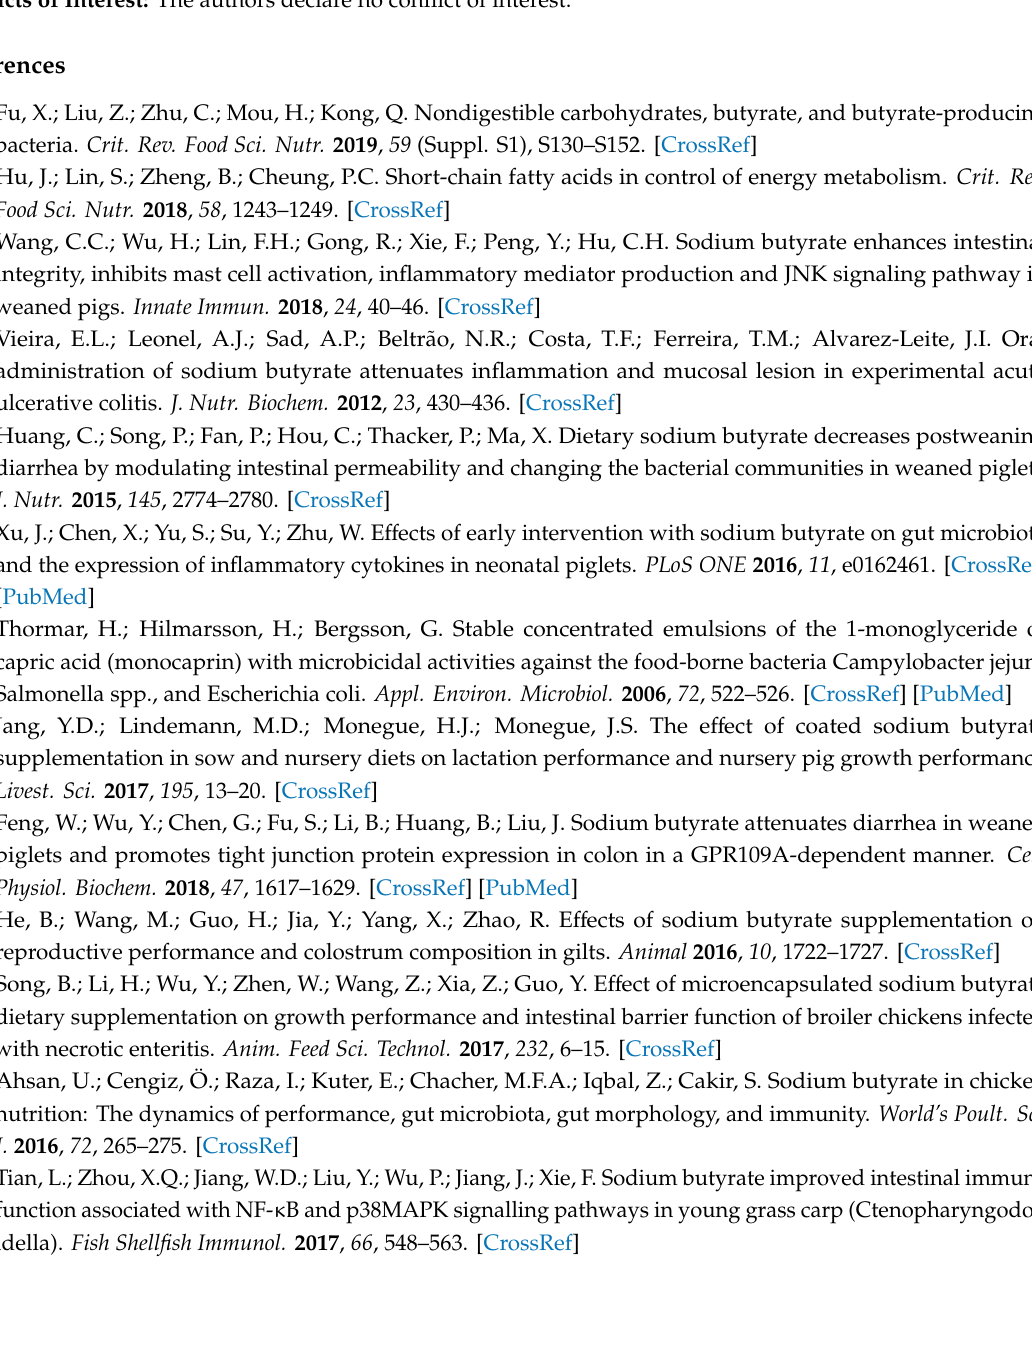
Table S1: Relative standard deviation (RSD) of the retention time of internal standard in QC. Table S2: Metabolites in the serum of growing pigs identified by gas chromatograph-mass spectrometry analysis. Table S3: Di ff erential metabolites between the Con group and SB group within the whole period. Table S4: Di ff erential metabolites between the Con group and SB group at 0 min. Table S5: Di ff erential metabolites between Con group and SB group at 30 min. Table S6: Di ff erential metabolites between Con group and SB group at 60 min. Table S7: Di ff erential metabolites between Con group and SB group at 120